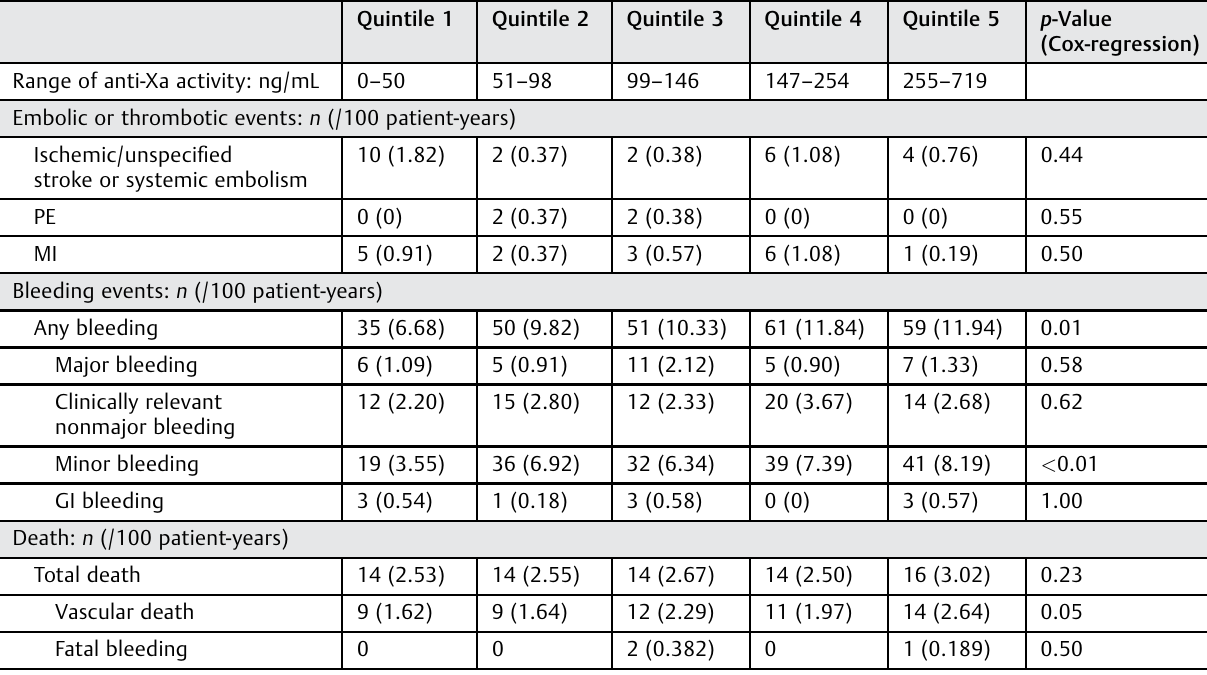
Table 2 Clinical events by apixaban anti-Xa activity